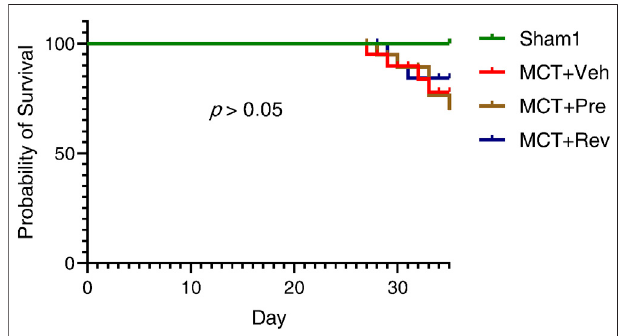
FIGURE 3 | Dapagli fl ozin could not reduce the mortality of MCT rats. Observed for fi ve weeks after MCT subcutaneous injection. ( n (cid:1) 6 for Sham1, n (cid:1) 15 for MCT + vehicle, MCT + prevention, and MCT +